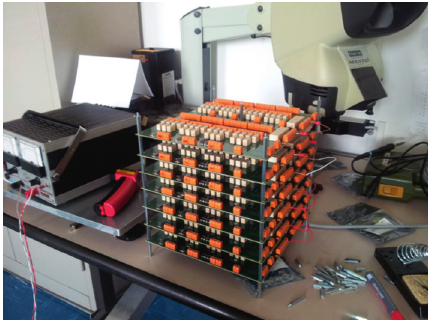
Figure 20: Pcbs cards used during the